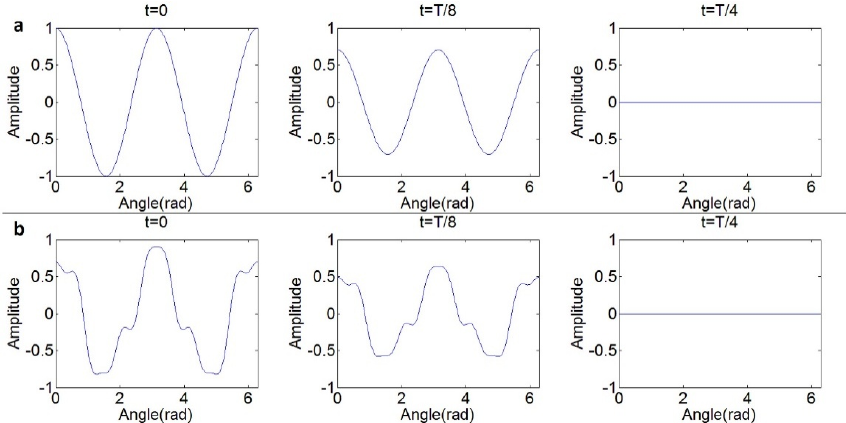
Figure 4. 𝑤 (cid:3043),(cid:3041) for different times. ( a ) Mode n = 2 of a simple disk structure (one diametrical Figure 4. w p , n for di ff erent times. ( a ) Mode n = 2 of a simple disk structure (one diametrical component). component). ( b ) Mode with more than one diametrical component. ( b ) Mode with more than one diametrical